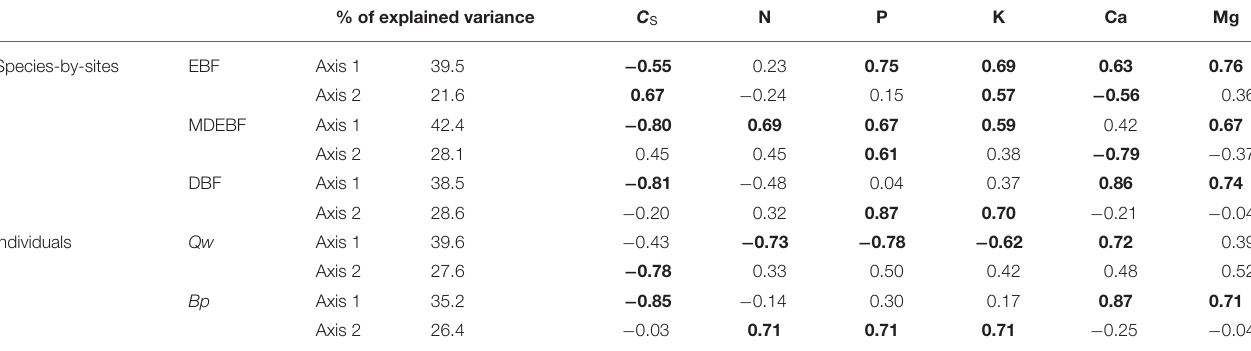
TABLE 2 | Extraction sums of squared loadings and loading scores of leaf C S , Ca, K, P, and N concentrations in the PCAs for individuals of two species and species by sites of three forest types. % of explained variance C S N P